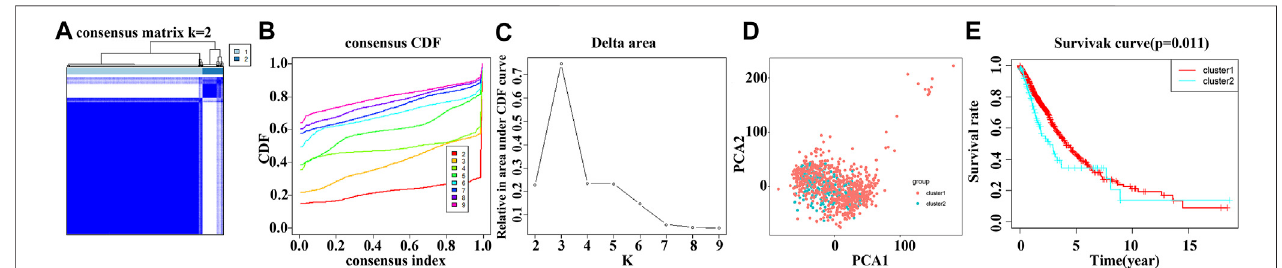
FIGURE 7 | Consensus clustering of risk model genes identi fi es dismal prognosis in NSCLC patients. (A – C) Consensus clustering of risk model genes; (D) Signi fi cant differences between the NSCLC patients of Cluster1 and Cluster2 groups using PCA analysis. (E) Survival time of NSCLC patients in Cluster1 and Cluster2 groups using survival analysis. NSCLC, non-small-cell lung cancer; PCA, principal component analysis.